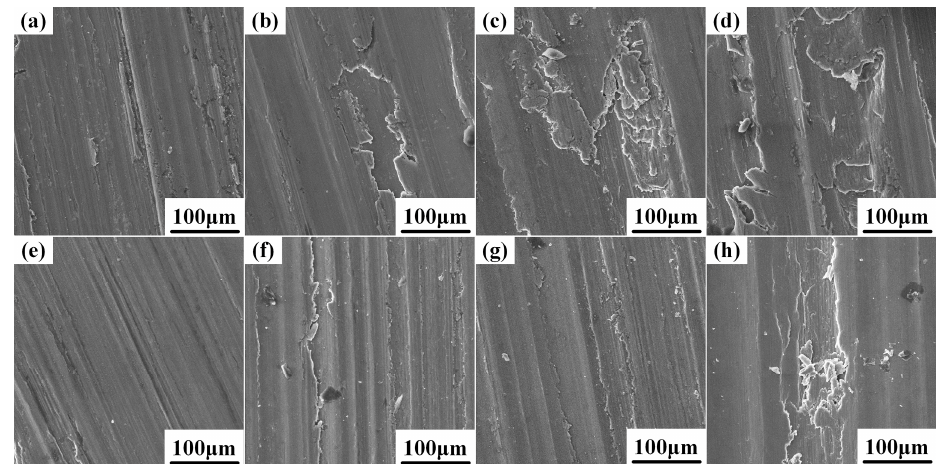
Figure 7. The worn surfaces of the Al-Cu matrix alloy and 0.5 wt.% nano-sized TiC p /Al-Cu composite